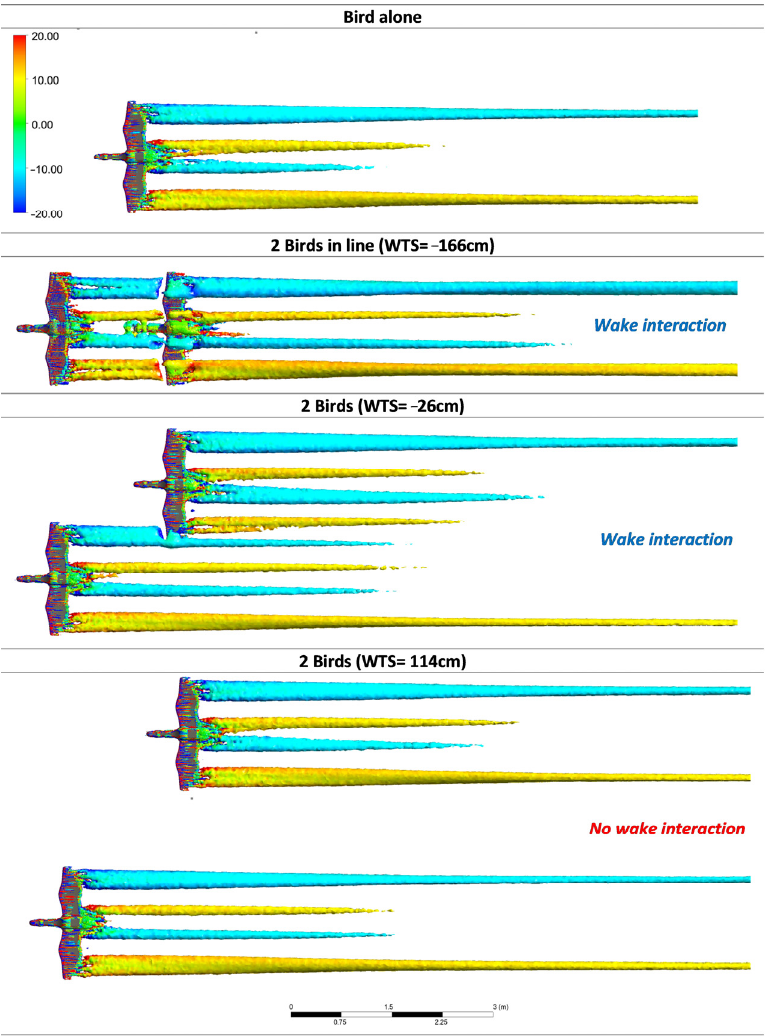
Figure 8. Isosurfaces colored by vorticity for the single bird, the birds in line (WTS = − 166 cm) and the birds offset by WTS = − 26 cm and WTS = 114 cm, respectively.